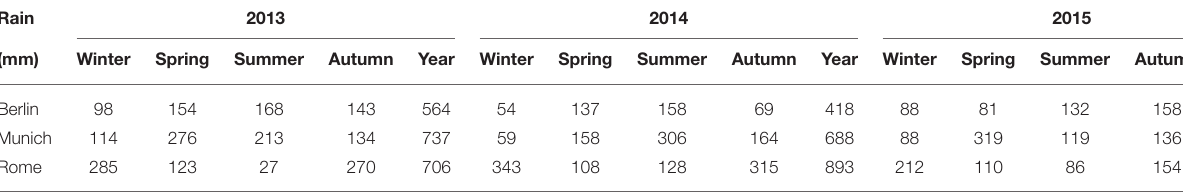
TABLE 4 | Seasonal and yearly cumulative precipitation. Rain